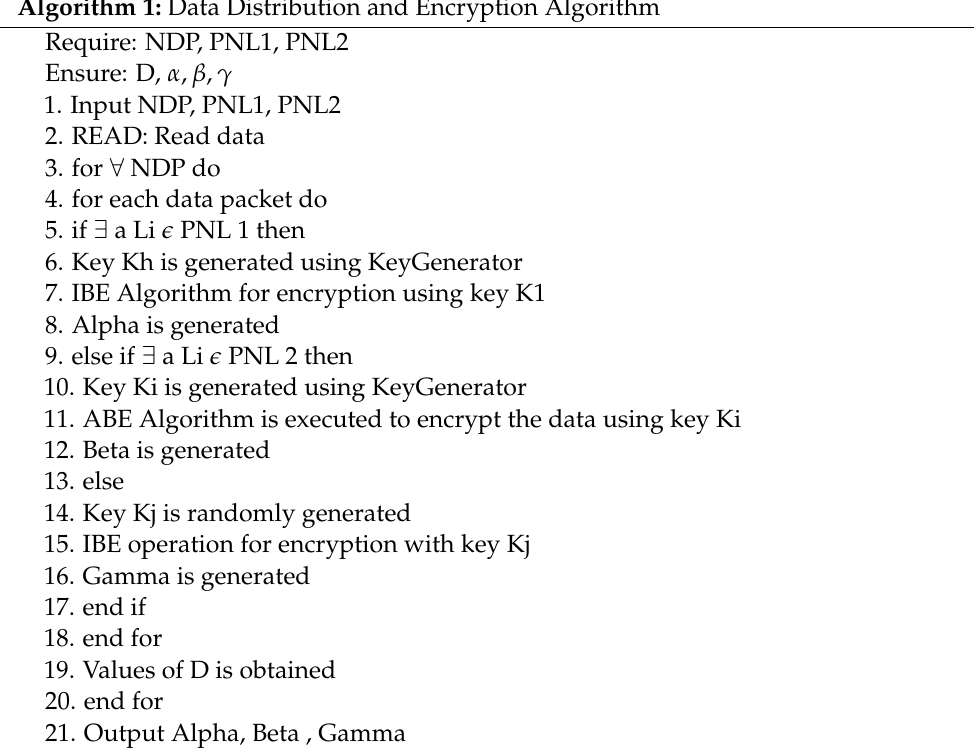
Algorithm 1: Data Distribution and Encryption